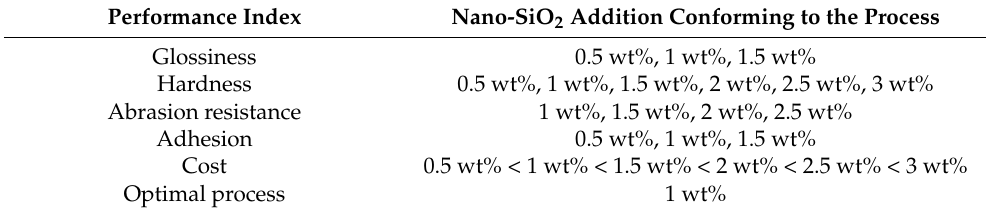
Table 2. The optimal amount of nano-SiO 2 addition for each performance